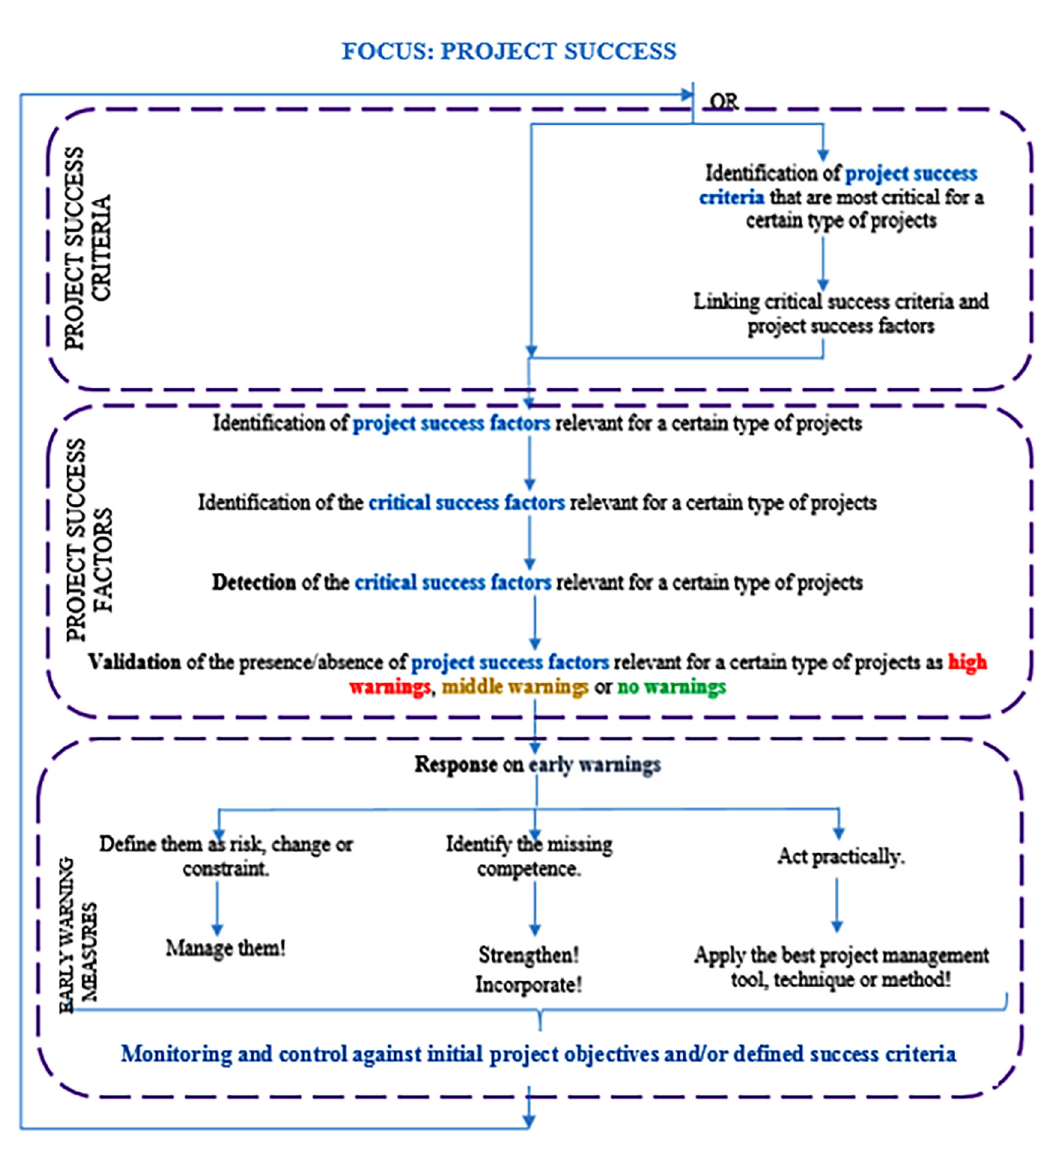
Figure 2. Early warning system’s